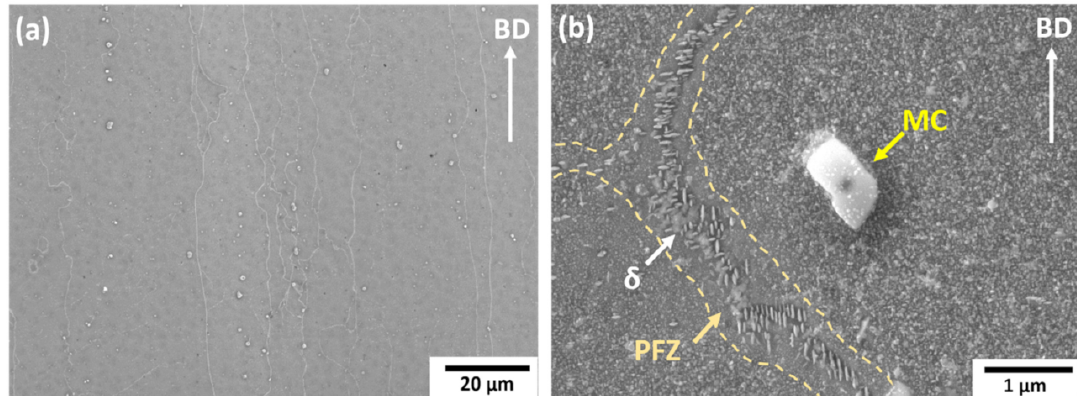
Figure 4. SEM micrographs showing grain morphology and precipitation along the grain boundary in as-built EBM IN718 parallel to the building direction, ( a ) at lower magnification and ( b ) at higher magnification. (BD: Building Direction, PFZ: Precipitate Free